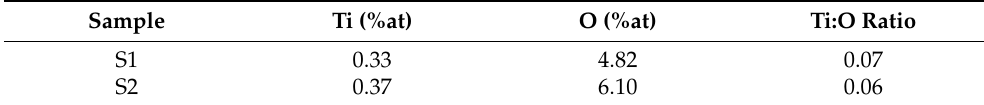
Figure 4. ( a ) Transmittance spectra and ( b ) Tauc’s plot for the TiO 2 films deposited at 0.17 (red dash line) and 0.89 Pa (blue line).